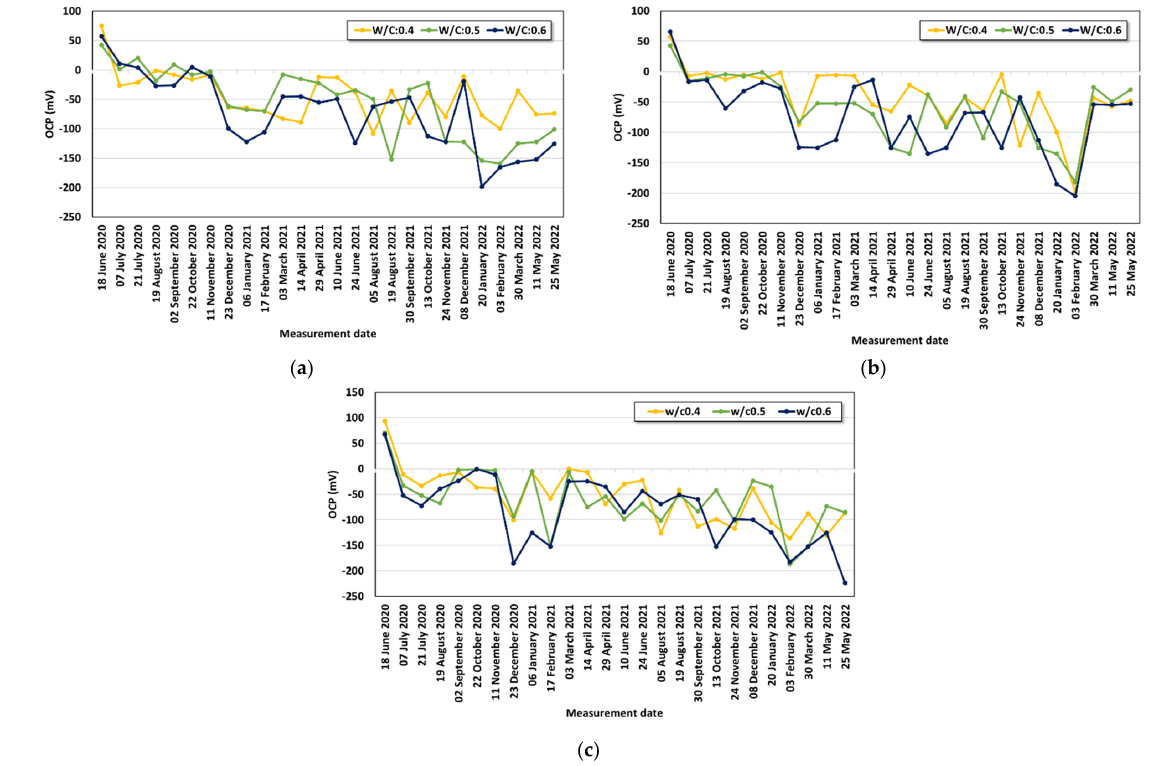
Figure 7. Open-circuit potential (OCP) evaluation under 0.0% chloride exposure conditions. Cover depths: ( a ) 60 mm, ( b ) 45 mm, and ( c ) 30 mm.